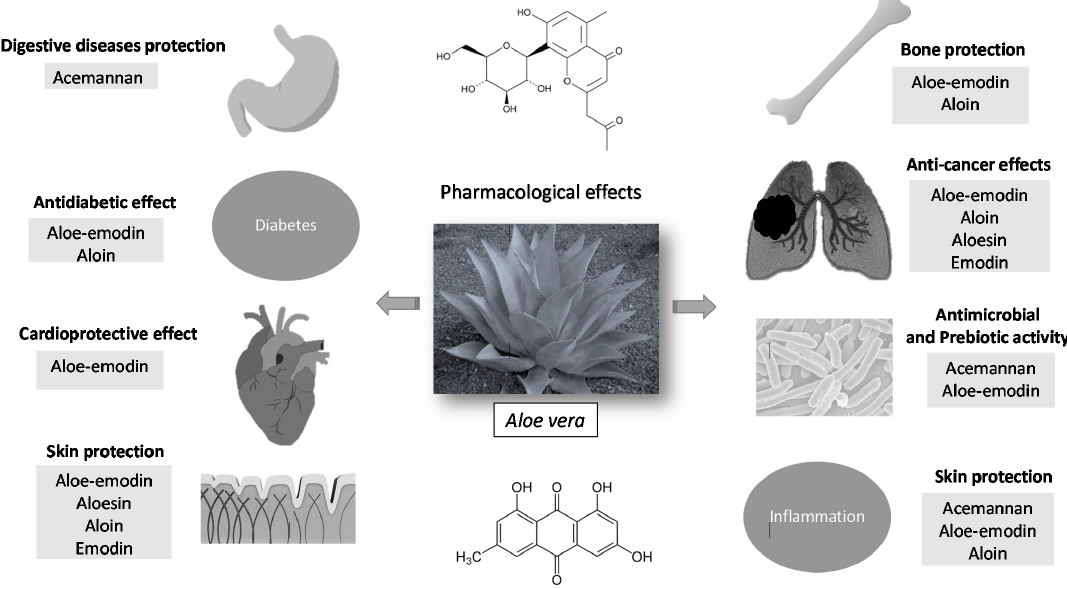
Figure 2. Pharmacological e ff ects of the main constituents of Aloe vera .